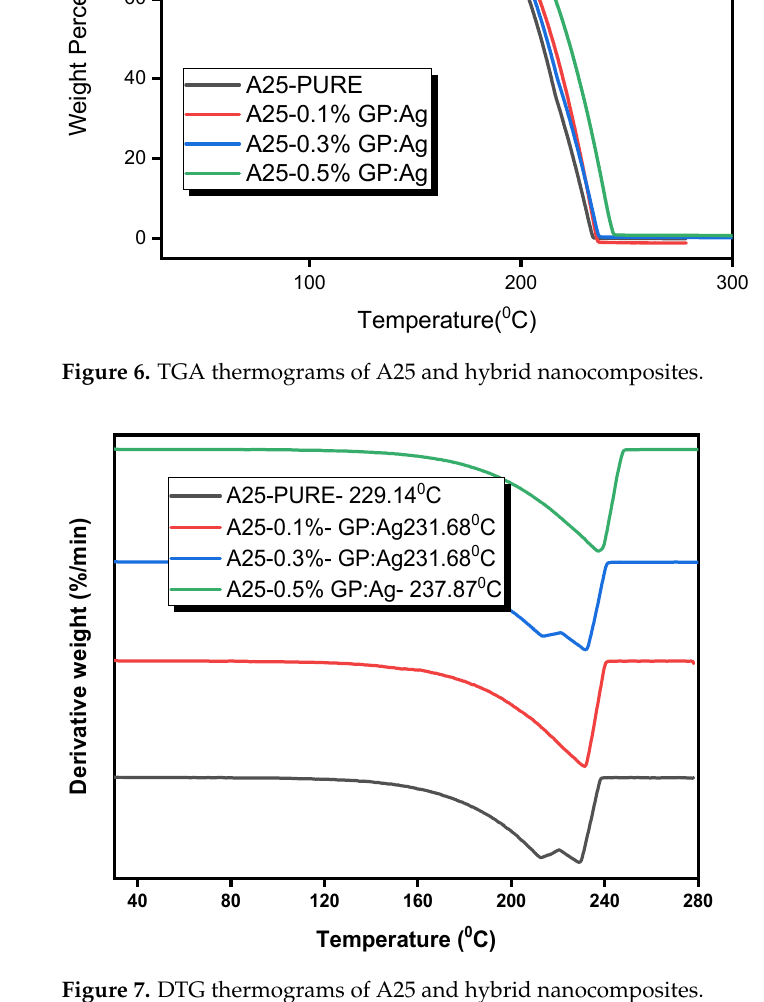
Figure 7. DTG thermograms of A25 and hybrid nanocomposites. Table 3. Thermal stability parameters of hybrid